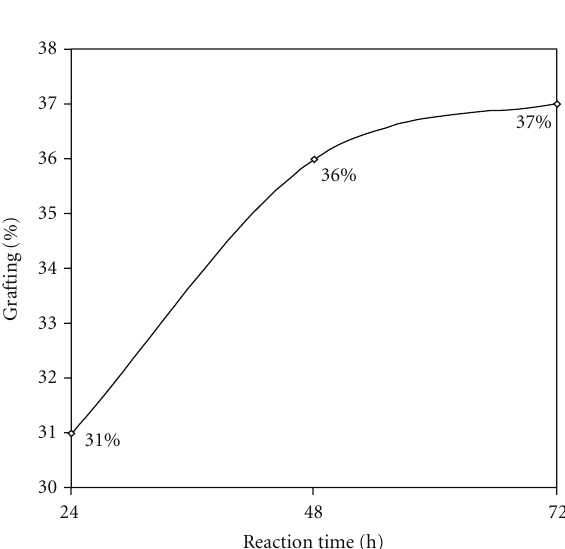
Figure 6: Grafting percent versus reaction